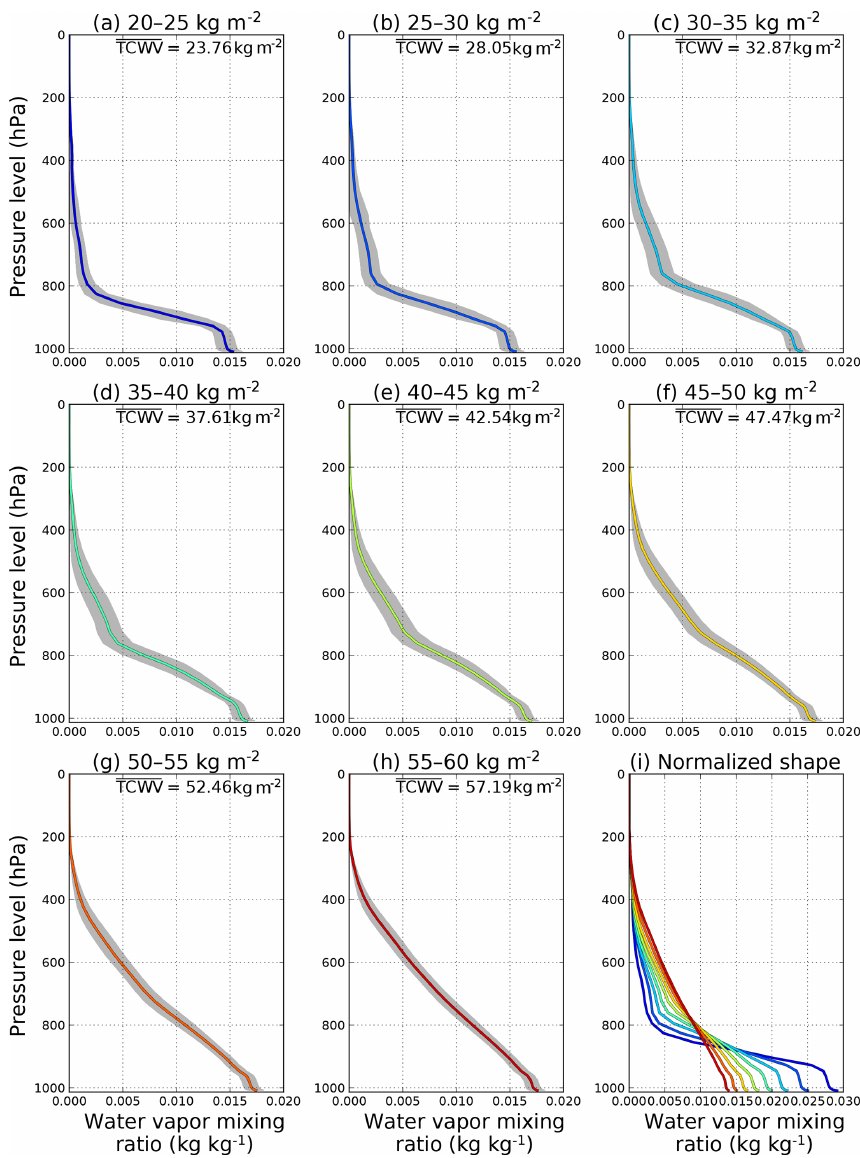
Figure 5. Statistical analysis of water vapor vertical profiles from ECMWF ERA-Interim reanalysis data over a small region of the Pacific Ocean (5 ◦ S–5 ◦ N, 180–170 ◦ W) in July 2008 to 2018. Water vapor profiles are sorted by their total column density into eight ranges, which are (a) 20–25kgm − 2 , (b) 25–30kgm − 2 , (c) 30–35kgm − 2 , (d) 35–40kgm − 2 , (e) 40–45kgm − 2 , (f) 45–50kgm − 2 , (g) 50–55kgm − 2 and (h) 55–60kgm − 2 . The shading indicates the 1 σ standard deviation variation of water vapor mixing ratio. Panel (i) shows the normalized mean water vapor profile shapes of these eight